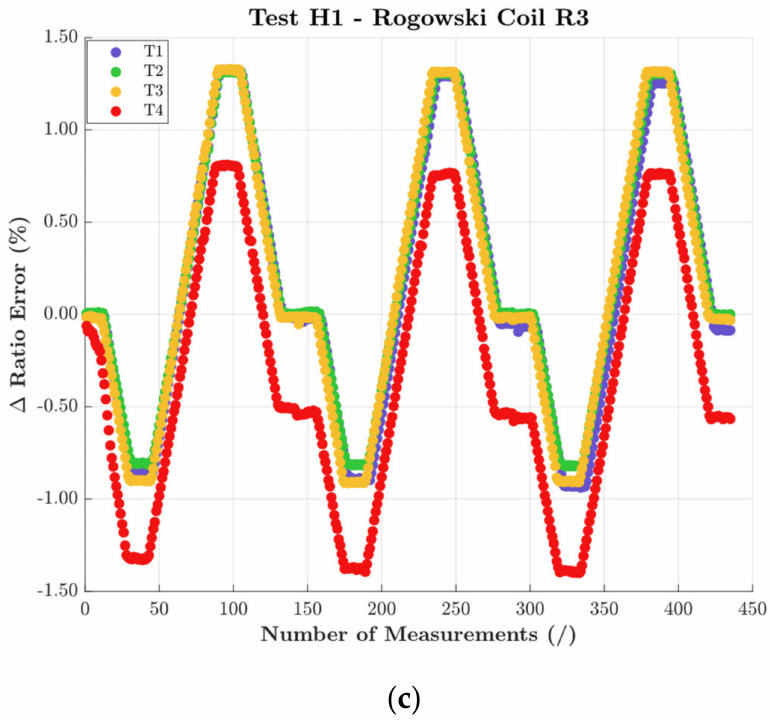
Figure 5. ε results of the test performed with H1 and all positions ( a ) R1, ( b ) R2, and ( c ) R3.